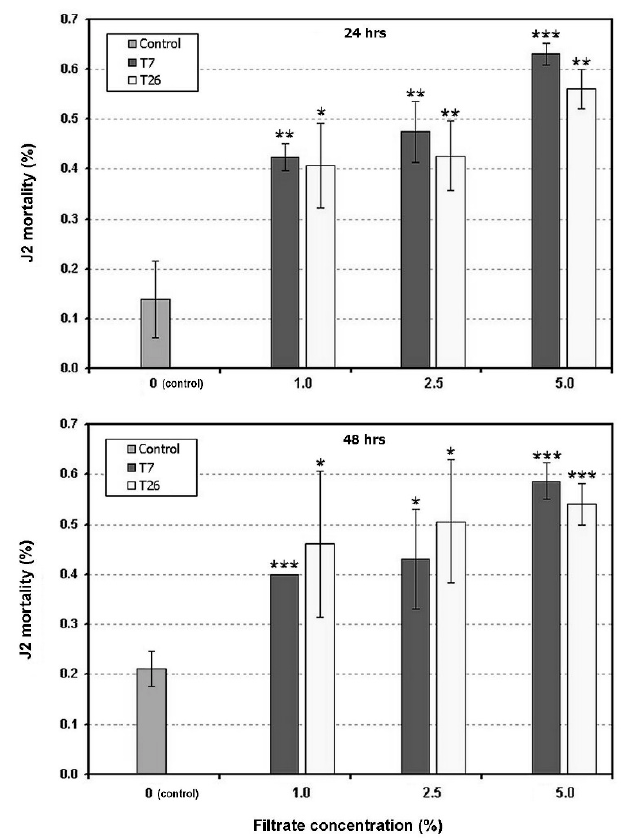
Figure 3. In vitro toxicity of the culture filtrates of the Trichoderma afroharzianum isolate T7 and T. harzianum i solate T26 on Meloidogyne incognita J2, after 24 and 48 h exposure at different filtrate concentrations, at 26 °C. The controls were a 50% dilution of the culture medium used for the fungal growth, without filtrate addition. Bars show the means ± SD. Asterisks show the means significantly different from the control at p < 0.05 (*), p < 0.01 (**) and p < 0.001 (***), as indicated by Student’s t test. The PCR-amplified products of the four TRI genes were obtained from the isolates T4, T25 and T26, but not T7, which only showed a faint band for the TRI-11 gene (Figure 4). The bands were eluted and sequenced. The BLAST analyses showed that they clustered with a Trichoderma harzianum hypothetical protein, with a high ( > 98%) nt-similarity (Table 2).